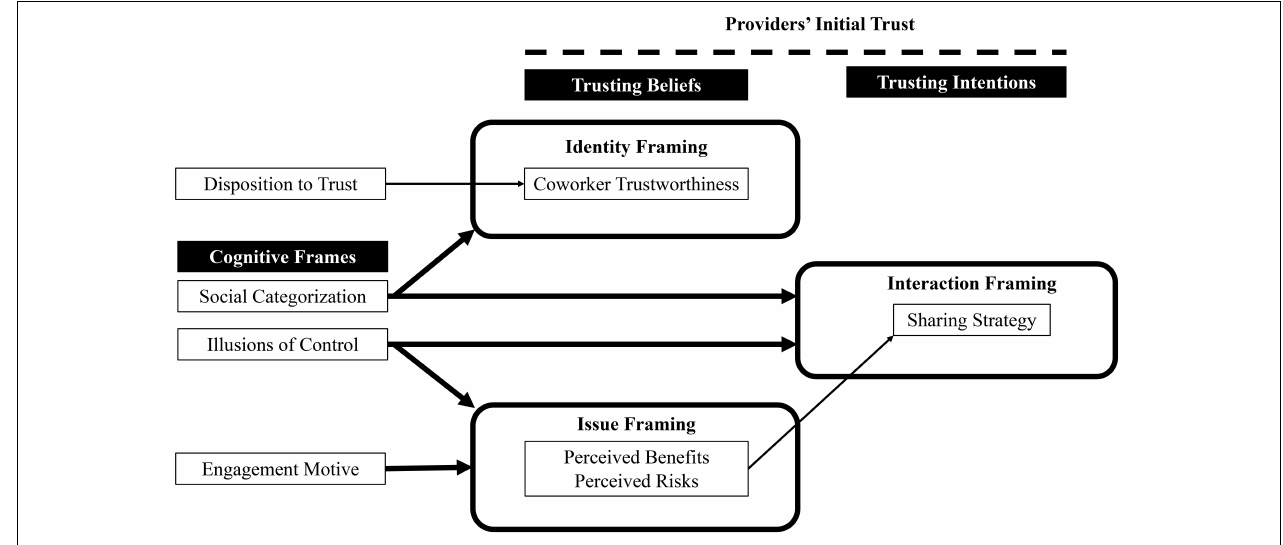
FIGURE 2 | Providers’ initial trust and the framing of collaborative consumption on an organization-sponsored sharing platform.